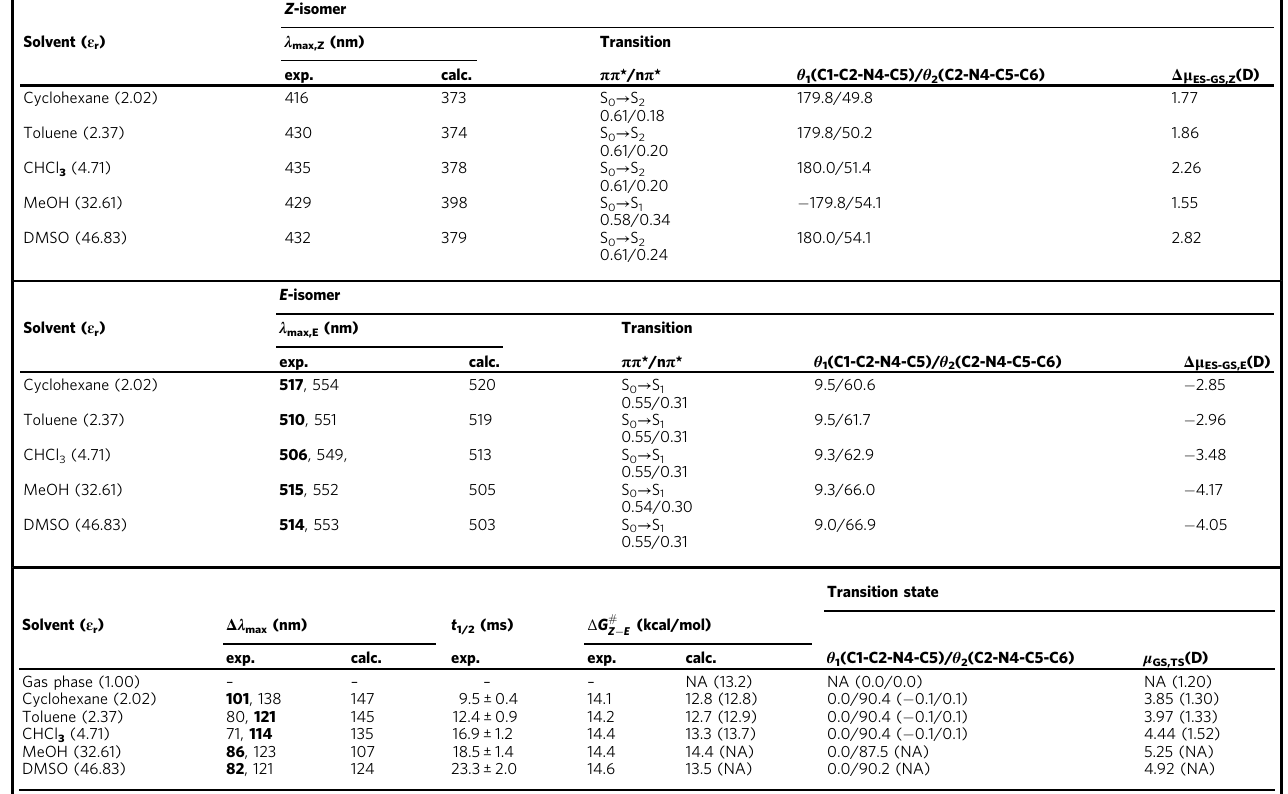
Table 1 Computational studies on solvents on ITI